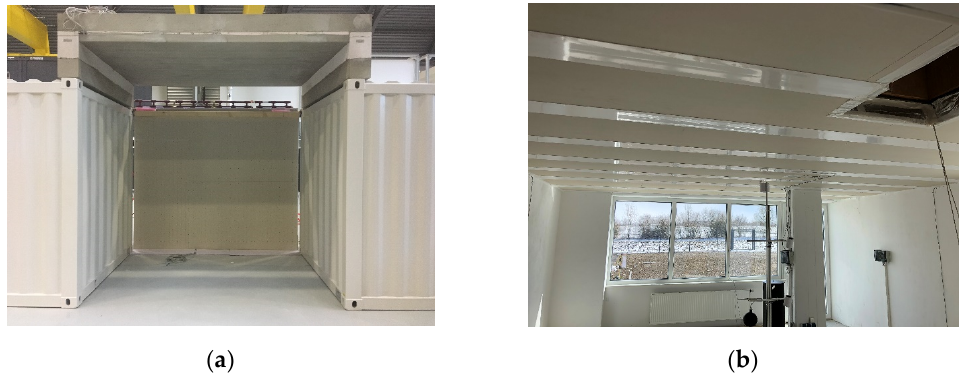
Figure 4. ( a ) New construction TABS storage in the IBP’s technical center before closing the 4th wall. ( b ) Retrofit TABS storage system in the twin house’s living room. Table 1. Charge and discharge sections of the experimental program of the two units of TABS storage. Experimental